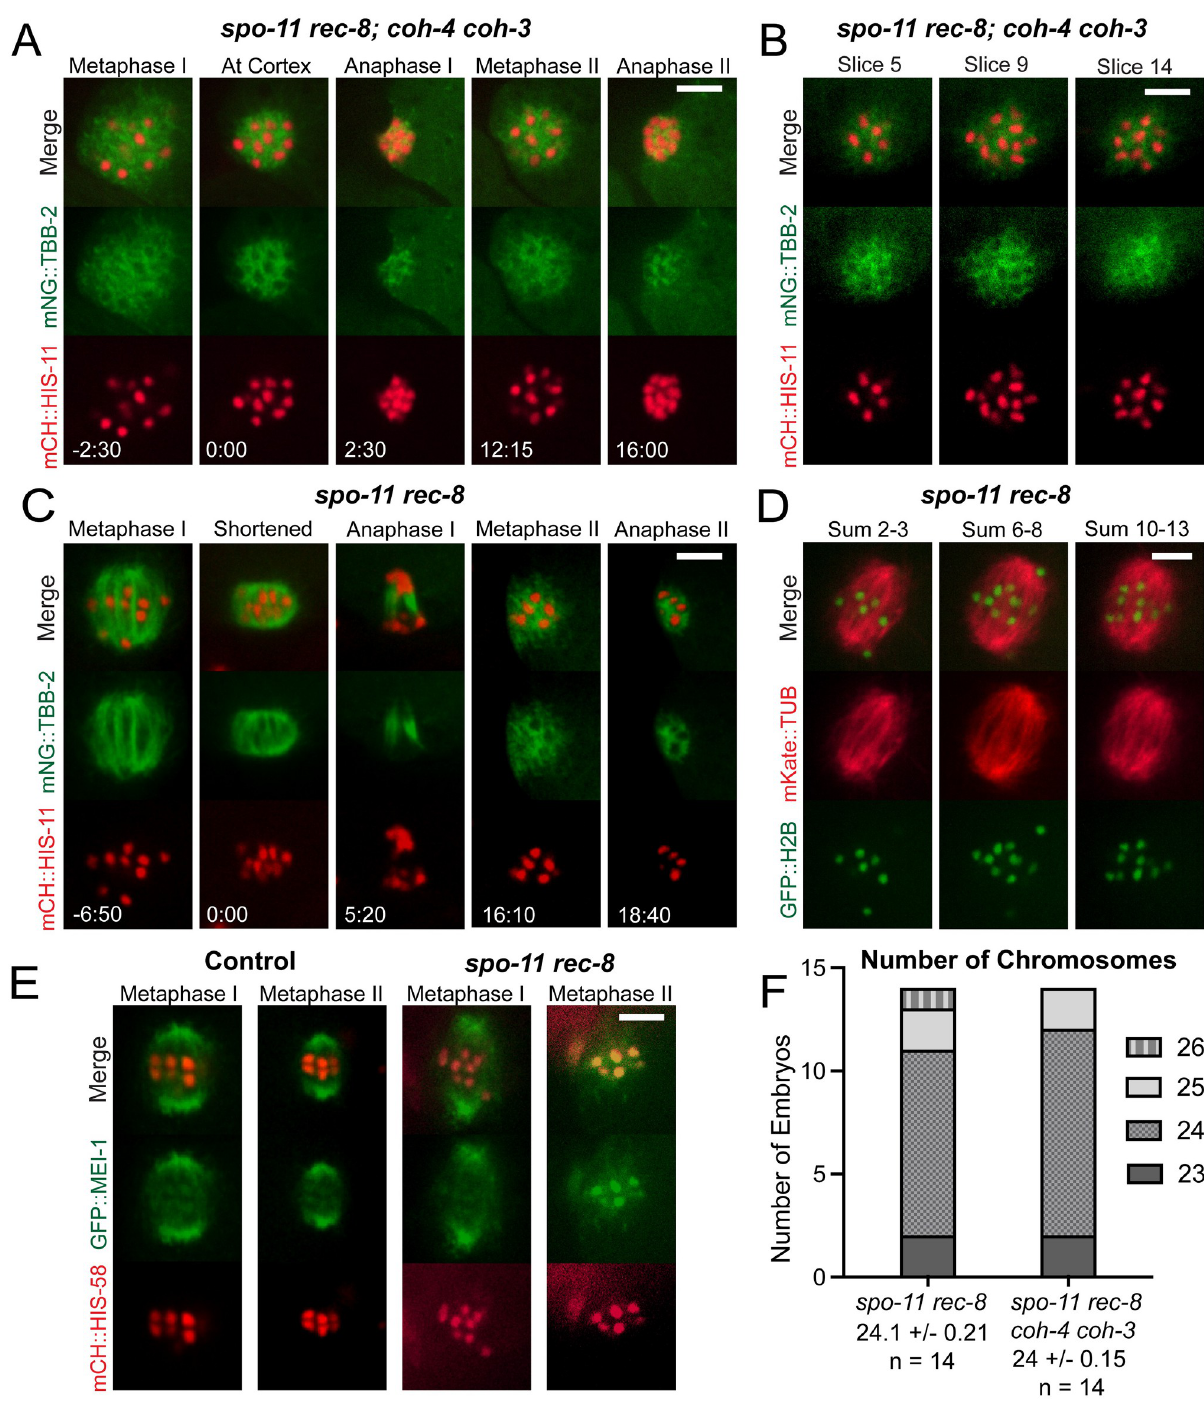
Fig 3. spo-11 rec-8; coh-4 coh-3 embryos have disorganized meiotic spindles whereas spo-11 rec-8 embryos have bipolar spindles in meiosis I. (A) Single-focal plane time-lapse imaging of a spo-11 rec-8; coh-4 coh-3 mutant expressing mNeonGreen::TBB-2 and mCherry::HIS. Disorganized spindles were observed in both MI and MII in 10/10 embryos. 0 minutes is the time when the MI spindle contacts the cortex. (B) Z-stack slices of a spo-11 rec-8; coh-4 coh-3 MI spindle show 24 chromatids with one chromatid visible in both slices 9 and 14. (C) Single-focal plane time-lapse imaging of 13/13 spo-11 rec-8 embryos show bipolar MI spindles which undergo anaphase chromosome separation and MII spindles which are disorganized and do not undergo anaphase chromosome separation. 0 minutes is the completion of MI spindle rotation. (D) Combined z-stack slices of a spo-11 rec-8 MI spindle show 24 chromatids. (E) Time-lapse imaging of spo-11 rec-8 embryos expressing GFP::MEI-1. 10/10 Control MI spindles, 5/5 Control MII spindles and 9/9 spo-11 rec-8 MI spindles were bipolar. 8/8 spo-11 rec-8 MII spindles were apolar. (F) Graph showing chromosome numbers during MI in both spo-11 rec-8 , and spo-11 rec-8; coh-4 coh-3 mutant embryos. All bars = 4 μ m.